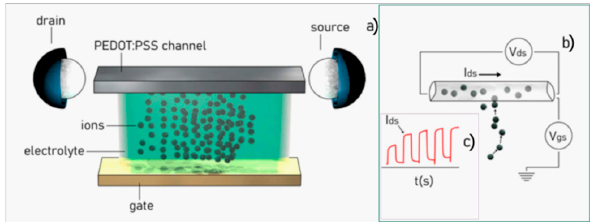
Figure 2. Scheme of a conventional organic electrochemical transistor (OECT) device, in which a solution is connected to the device through the gate, source and gate electrodes, and a conductive polymer channel ( a ). Upon application of an external voltage at the gate and the drain ( b ), a current of ions flows to the source generating a continuous function of time ( c ).